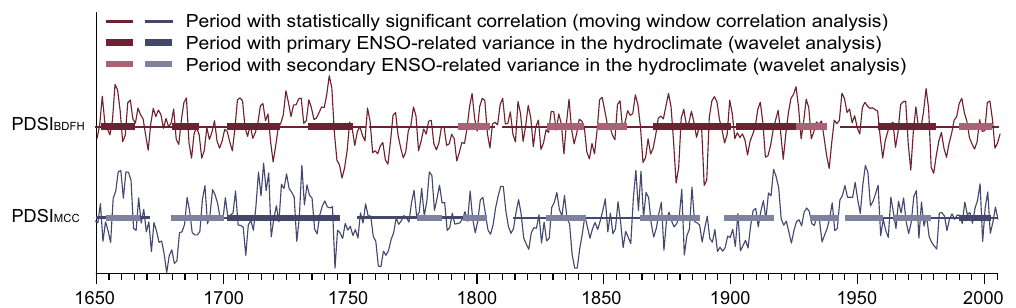
Figure 7. Periods with evidence of ENSO-related hydrological variability in March–May hydroclimate of mainland Southeast Asia over the period of 1650–2004. The periods with statistically significant correlation between the time series of ENSO UEP and PDSI BDFH and PDSI MCC are shown with thin horizontal lines, and the periods with primary and secondary ENSO-related variance (see definitions in Table 2) in PDSI BDFH and PDSI MCC are shown with thick horizontal